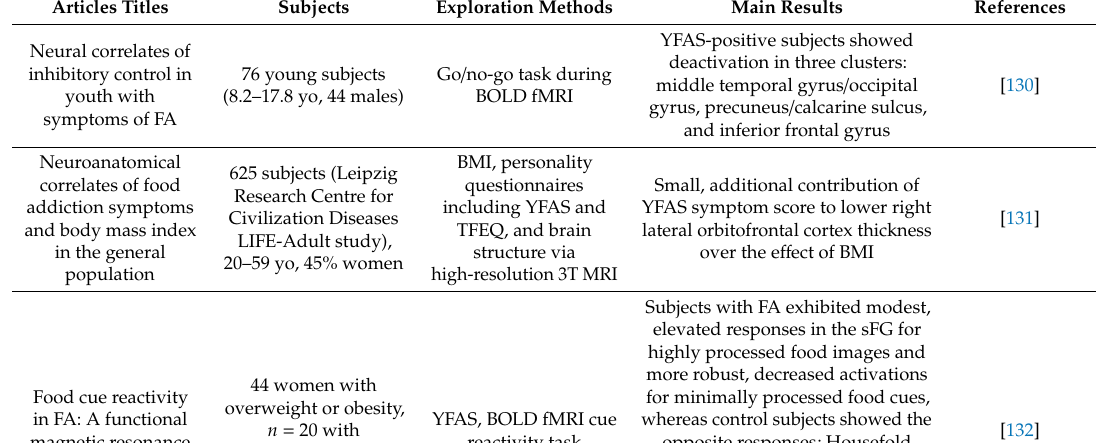
Table 2. Studies investigating the brain anatomical or functional specificities associated with YFAS-diagnosed food addiction (FA) in the human. Exploration